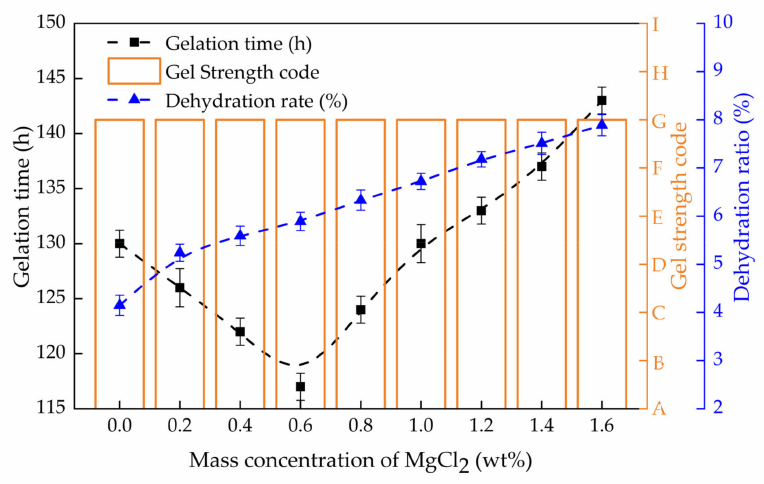
Figure 11. Dehydration rate of PHRO in different concentrations of MgCl 2